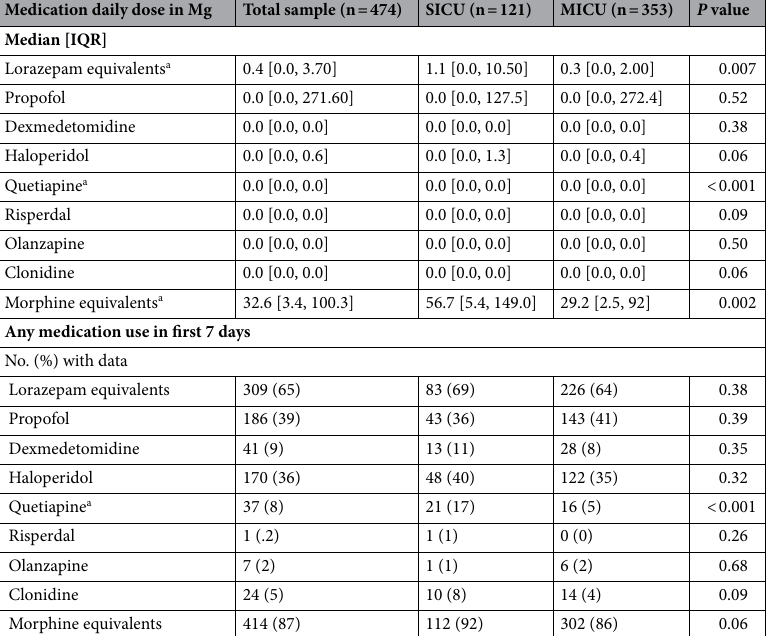
Table 2. Sedative, opioid, and psychotropic medication use. This table presents doses of sedative, opioid, and psychotropic medications compared between SICU and MICU, expressed as medication daily dose and number of patients who received that medication during the first 7 days. SICU surgical intensive care unit, MICU medical intensive care unit, Mg milligrams, IQR interquartile range, No. number. a Statistically significant differences between MICU and